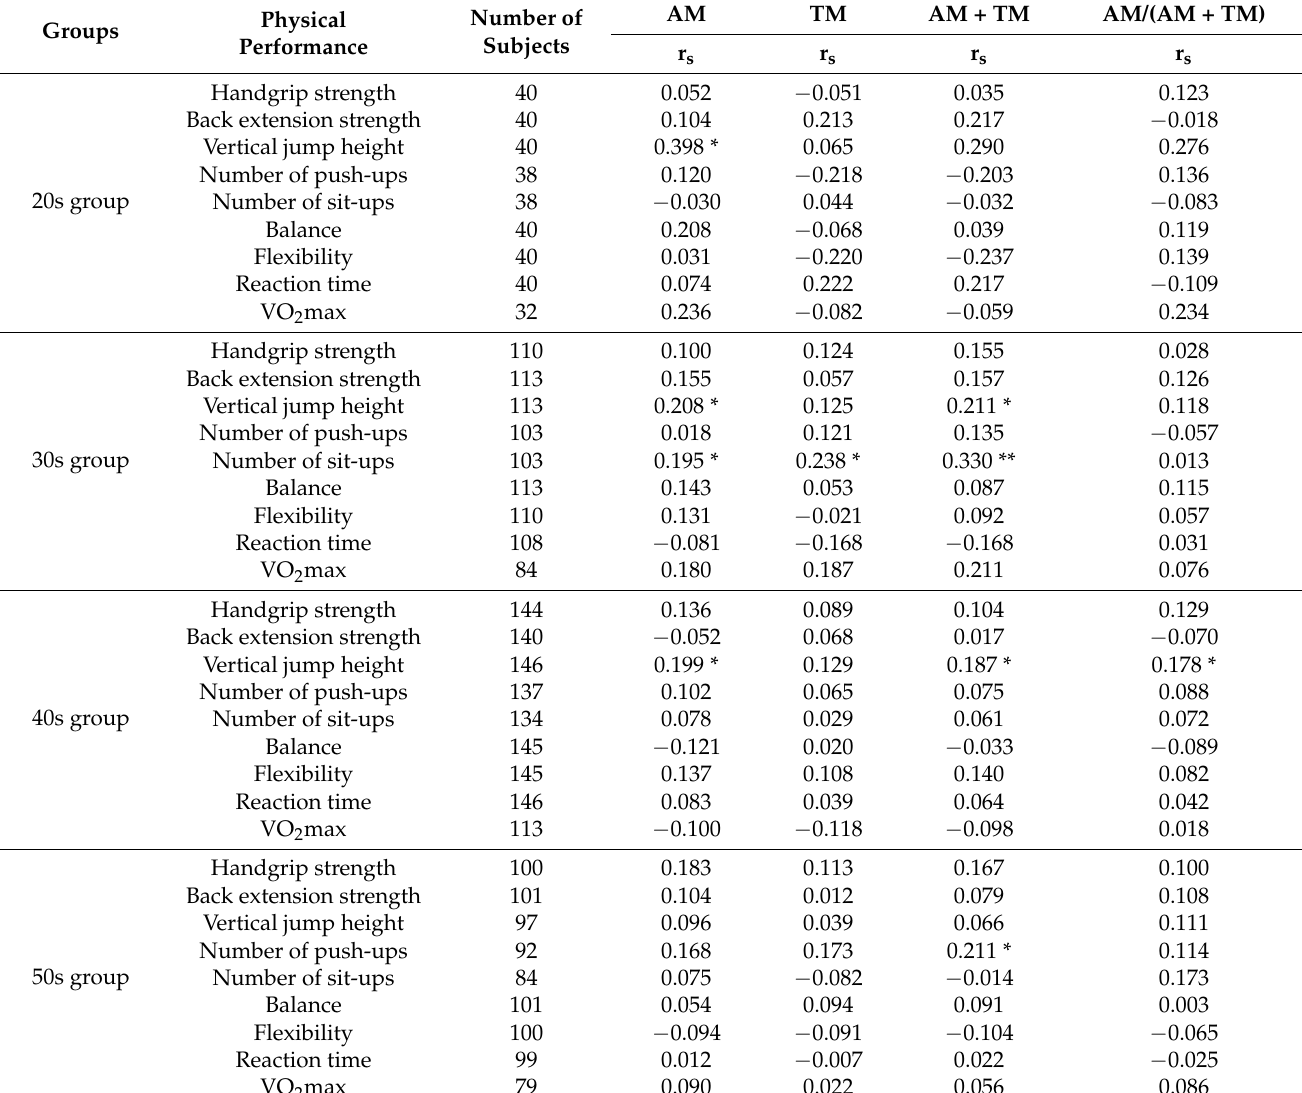
Table 4. Correlation between respiratory movements and physical